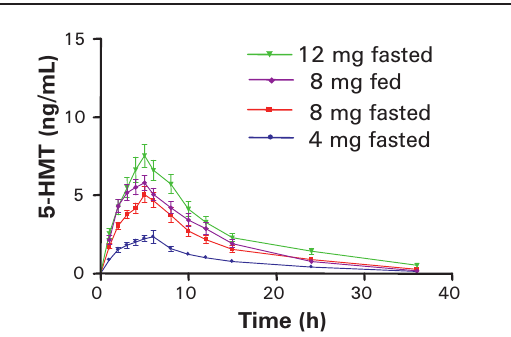
Figure 1 Plasma concentra- tions of 5-HMT after administration of feso- terodine in healthy subjects irrespective of CYP2D6 status. Data are presented as means ± standard error of the mean (SEM).